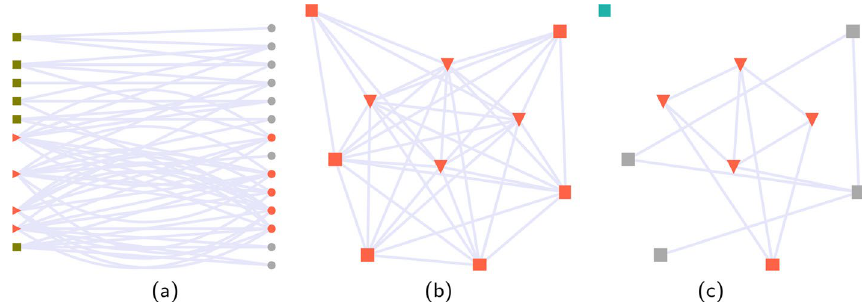
Fig. 2 Toy example: results for an interaction network based on users and hashtags. a Bipartite network of users and hashtags. Gray squares: normal users, red triangles: flagged users, gray circles: hashtags, red circles: hashtags used mainly by flagged users b Projected bipartite network on the user layer. Squares: normal users, triangles: flagged users. Node colour represents community membership c Filtered projected bipartite network on the user layer. Squares: normal users, triangles: flagged users. Node colour represents community